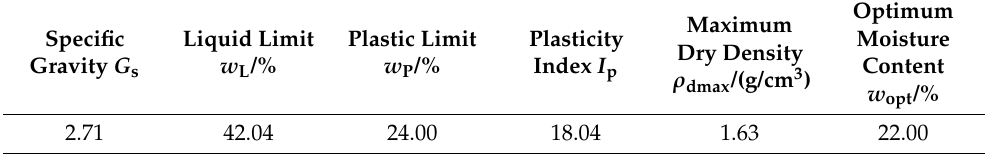
Table 1. Main physical indexes of clay.